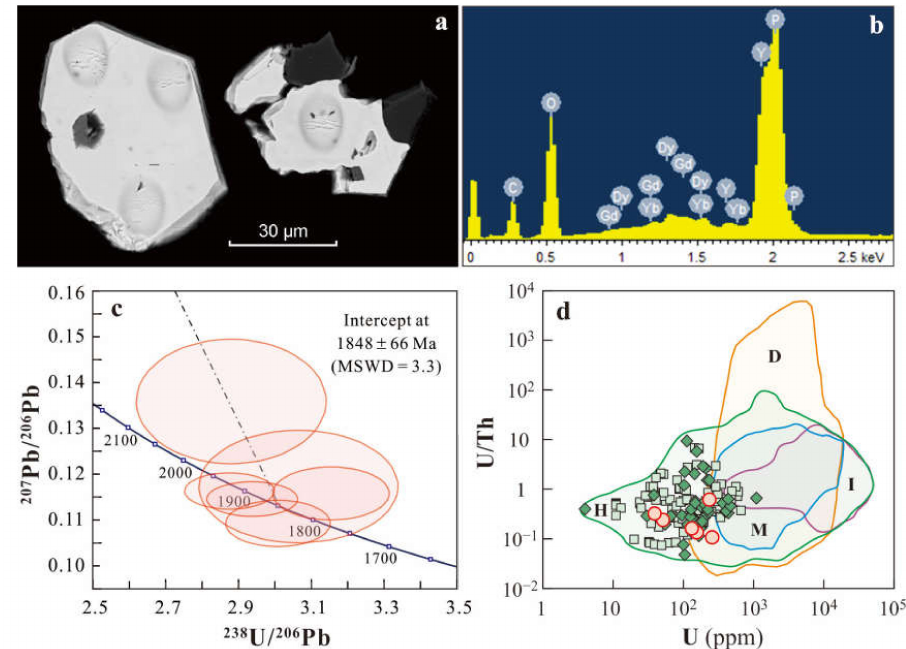
Figure 6. ( a ) Backscattered electron (BSE) images of representative xenotime grains. ( b ) Energy- dispersive spectrometer (EDS) semiquantitative analyses of xenotime. ( c ) Tera–Wasserburg concordia diagram for the xenotime dates. ( d ) U/Th–U diagram for different genetic types of xenotime. The shadowed fields summarize the igneous (I), metamorphic (M), diagenetic (D), and hydrothermal (H) xenotimes (data from [68]), with hydrothermal xenotime from iron (squares; data were collected from [69,70]) and gold (diamonds; data were collected from [71,72]) deposits highlighted. The circles are xenotime from the dolomite-bearing chlorite schist in this